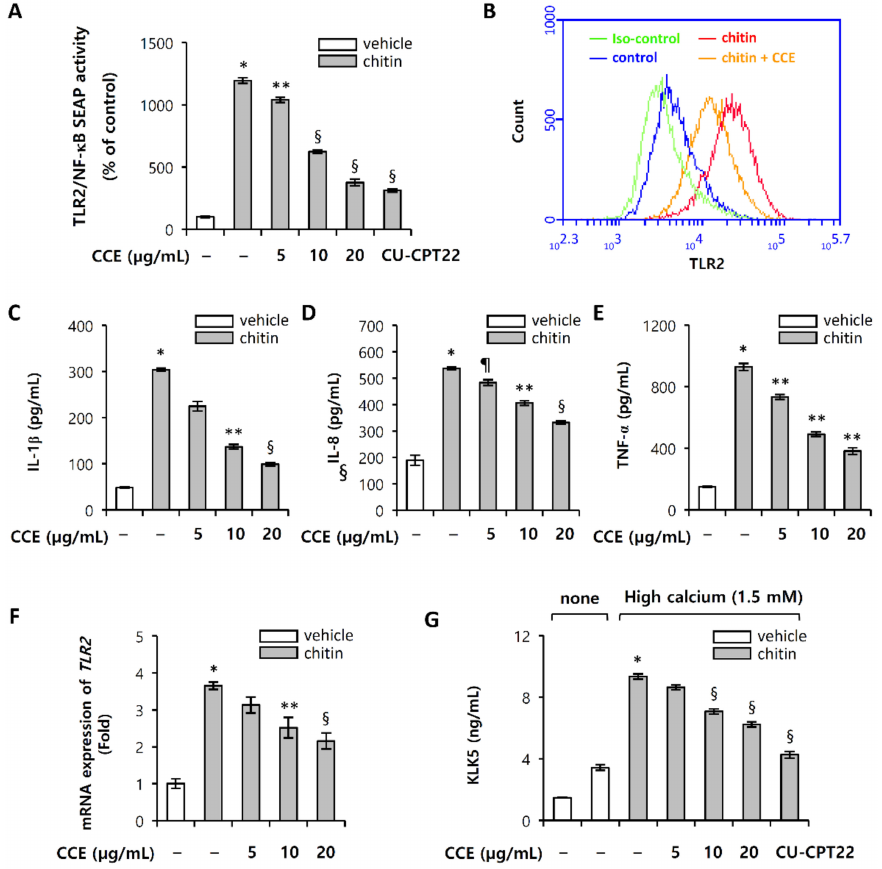
Figure 6. Chitin-induced TLR2 signaling pathways are regulated by CCE. ( A ) HEK-hTLR2 cells were cultured in DMEM containing 10% FBS, 100 µ g / mL Normocin ™ , and 1 × HEK-Blue ™ Selection. HEK-hTLR2 cells were pretreated with (5, 10, or 20) µ g / mL CCE and CU-CPT22 (200 nM), a TLR2 / 1 antagonist, for 1 h, and subsequently treated with 100 µ g / mL chitin for 12 h. TLR2 / NF- κ B 006B -induced SEAP activity was determined by reading the OD at 655 nm. ( B ) THP-1 was pretreated with 20 µ g / mL CCE, and subsequently treated with 100 µ g / mL chitin for 24 h. Cells were harvested, and stained with monoclonal TLR2-fluorescein isothiocyanate (FITC) antibody and mouse IgG2a kappa Isotype Control-FITC. TLR2 expression was analyzed by flow cytometry. ( C – E ) Pro-inflammatory cytokine protein was measured by ELISA. ( F , G ) HEKn (passage 4) was pretreated with 5, 10, or 20 µ g / mL CCE and 200 nM CU-CPT22, a TLR2 / 1 antagonist, for 1 h, and subsequently treated with 100 µ g / mL chitin for (48 or 72) h. TLR2 mRNA was measured by quantitative real-time PCR at 48 h. mRNA expression was normalized as the relative expression of GAPDH mRNA, and all data are presented as fold induction against control. The expression of KLK5 protein was measured by ELISA at 72 h. The results are mean ± standard deviation (SD) ( n = 3). * p < 0.001 vs. vehicle control; § p < 0.001 vs. chitin-treated control; ** p < 0.01 vs. vehicle control; p < 0.05 vs. vehicle control; phosphate-bu ff ered saline (PBS) vehicle control